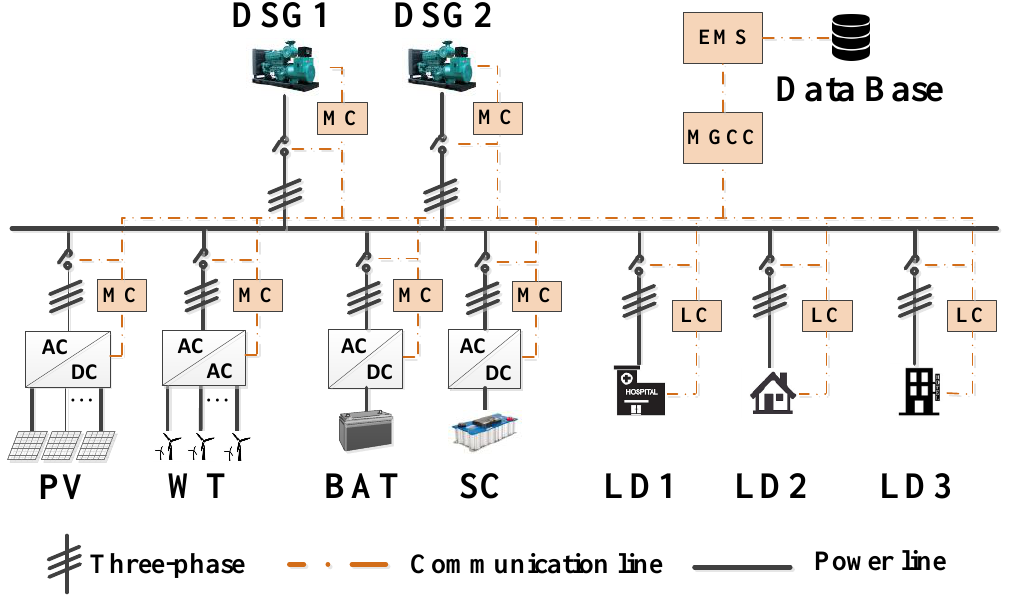
Figure 1. A typical topology of MG with HESS.